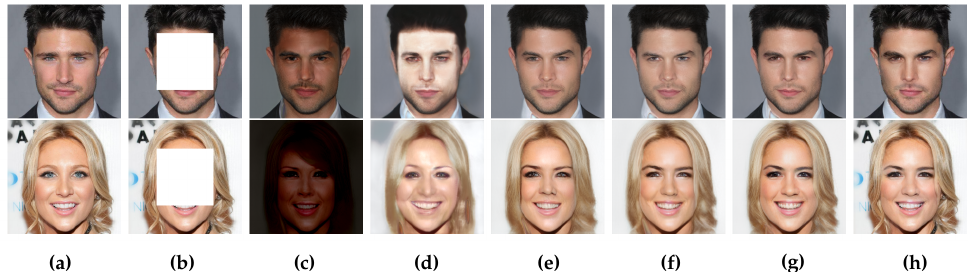
Figure 5. Comparison of completion results with the combination of different types of loss functions. ( a ) Original images, ( b ) Masked images, ( c ) Generated images by using Loss VGG loss, ( d ) Generated images by using Loss VGG and Loss L losses, ( e ) Generated images by using Loss VGG and Loss Log - Cosh 2 losses, ( f ) Generated images by using Loss VGG , Loss Log - Cosh and Loss MS - SSIM losses, ( g ) Generated images by using Loss VGG , Loss Log - Cosh , Loss MS - SSIM and Loss - LPIPS losses, ( h ) are the inpainted images obtained by Poisson fusion on the basis of ( f ).